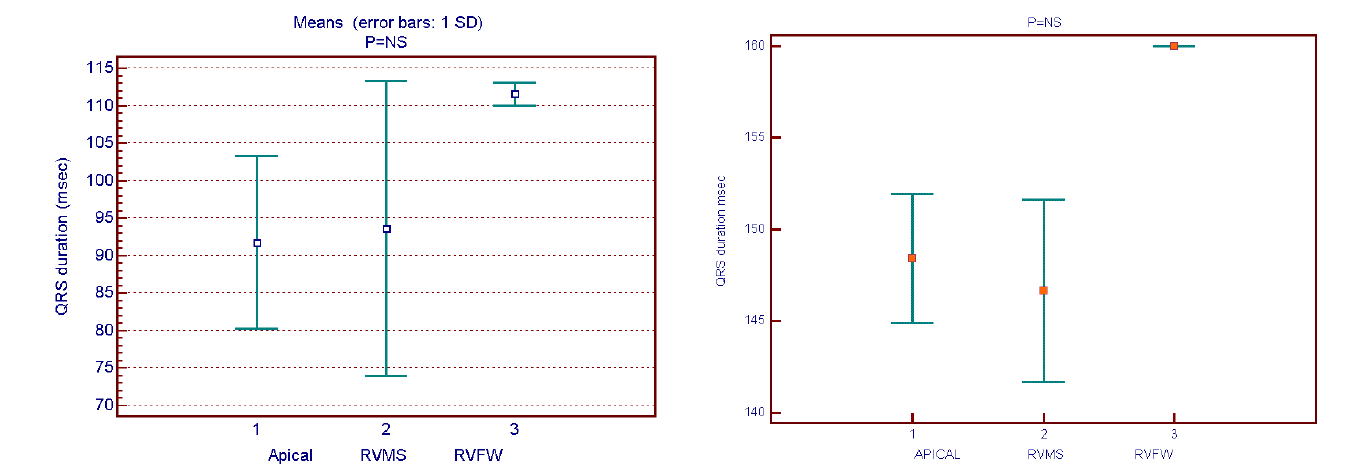
Fig. 1 - QRS on lead DII during echocardiogram (ms). RVFW=Right ventricle free wall; RVMS=Right ventricle medium septum